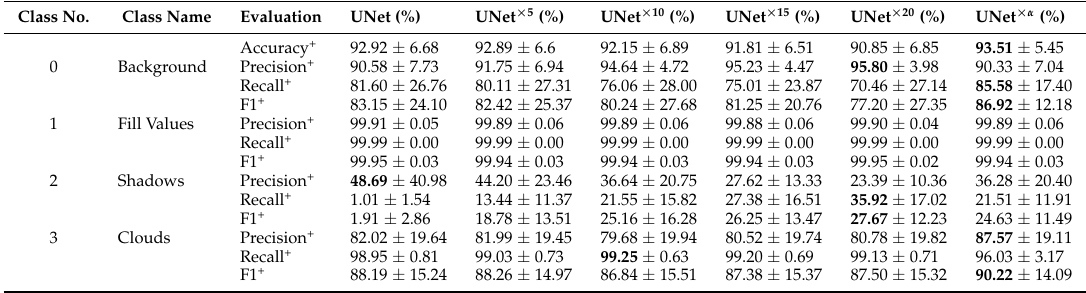
Figure 7. Local examples of cloud and shadow segmentation (L8, Path 113, Row 26). From left to right are false-color images, references, and results of Refined UNet. Bands 5 NIR, 4 Red, and 3 Green are combined together as RGB channels to construct a false-color image for visualization. Visually, Refined UNet can obtain more precise contours of clouds and shadows compared to references, which leads to finer detection results. Some patches of shadows, however, might be eliminated due to the over-refinement, which should be further taken into consideration and solved in the future. Table 2. Average scores of accuracy, precision, recall, and F1 for multiple UNet models with Dense CRF refinement. The top results are highlighted in bold. Class